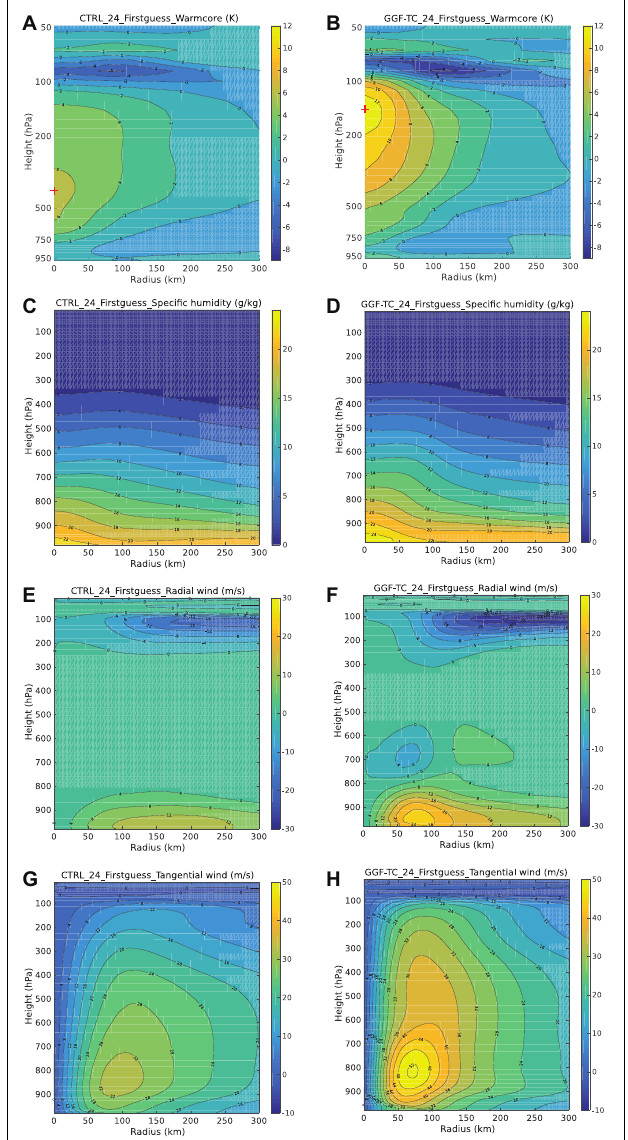
FIGURE 11 | Same as Figure 10 , radius-height cross sections of (A,B) temperature anomaly that has the mean temperature in a 1000 km radius deducted for each level, (C,D) specific humidity, (E,F) radial wind, and (G,H) tangential wind at 1200 UTC 24 October 2018. Left panels for experiment CTRL, and right panels for experiment